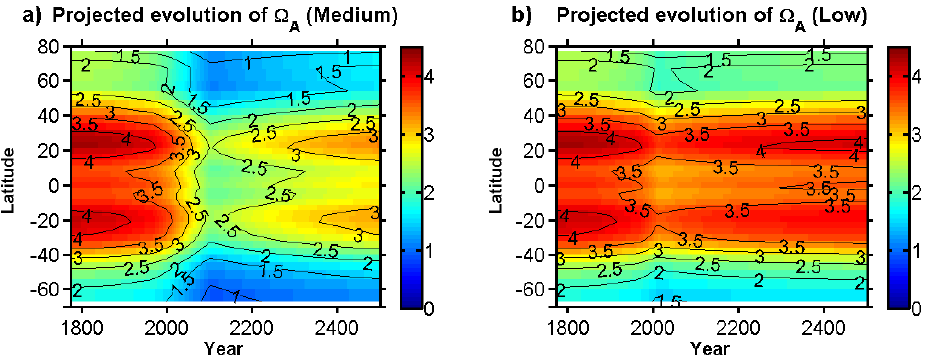
Fig. 17. Modeled evolution of zonal annual mean surface aragonite saturation state of the (a) Medium and (b) Low emission commitment scenario and the CALARAG model